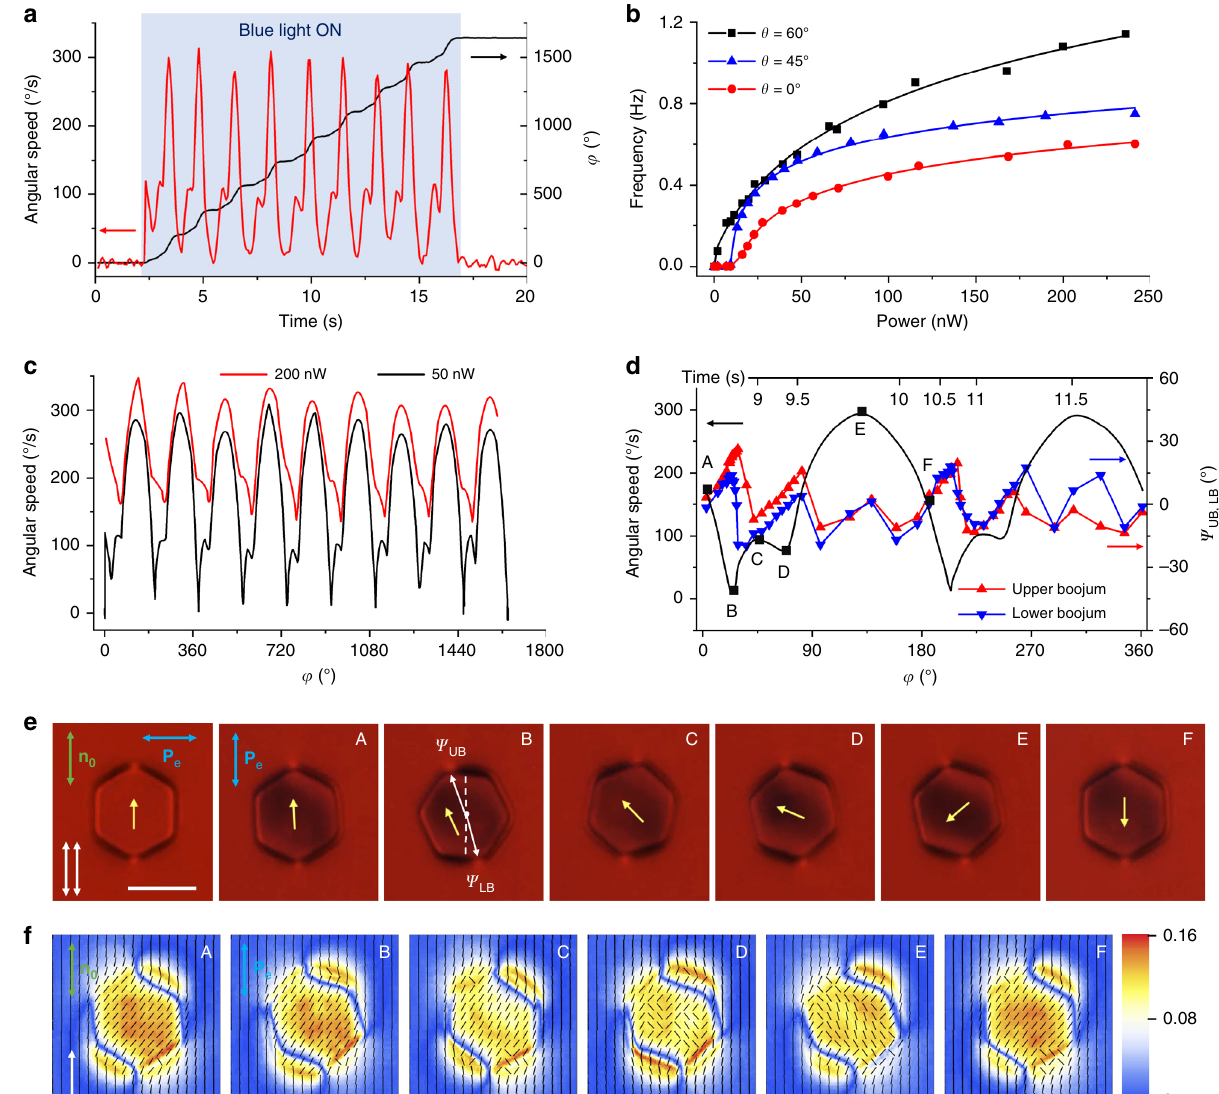
Fig. 2 Characterization of light-driven colloidal spinning motion. a Angular speed and the net azimuthal rotation angle φ versus time probed upon turning the blue excitation light on and then off. b Frequency of rotation versus optical power of light incident on the colloidal platelet at different angles θ between P e and n 0 . Symbols represent experimental measurements and solid lines are for eye guiding. c Angular speed versus φ at different powers of incident light. d Angular speed versus φ within a single full rotation compared to respective angular variations of angles ψ UB and ψ LB characterizing orientations of vectors that connect particle ’ s center of mass with upper and lower boojums, respectively, as marked in e . e Polarizing optical micrographs, obtained for samples placed in-between parallel linear polarizers along n 0 , with the angular positions (shown by yellow arrows) correlated with different angular positions in the dependencies shown in d . f Spatial patterns of polarization state of the red imaging light after passing through the sample. Thin black rods indicate orientation of the long axes of the polarization ellipses and background color ranging from blue to red represents distribution of the absolute value of ellipticity of the polarization ellipse. Labels a – f correlate these polarization ellipse data to the polarizing micrographs at the same angular positions shown in e . Incident imaging light is polarized along n 0 as shown by the white double arrow. Scale bars are 5 µ